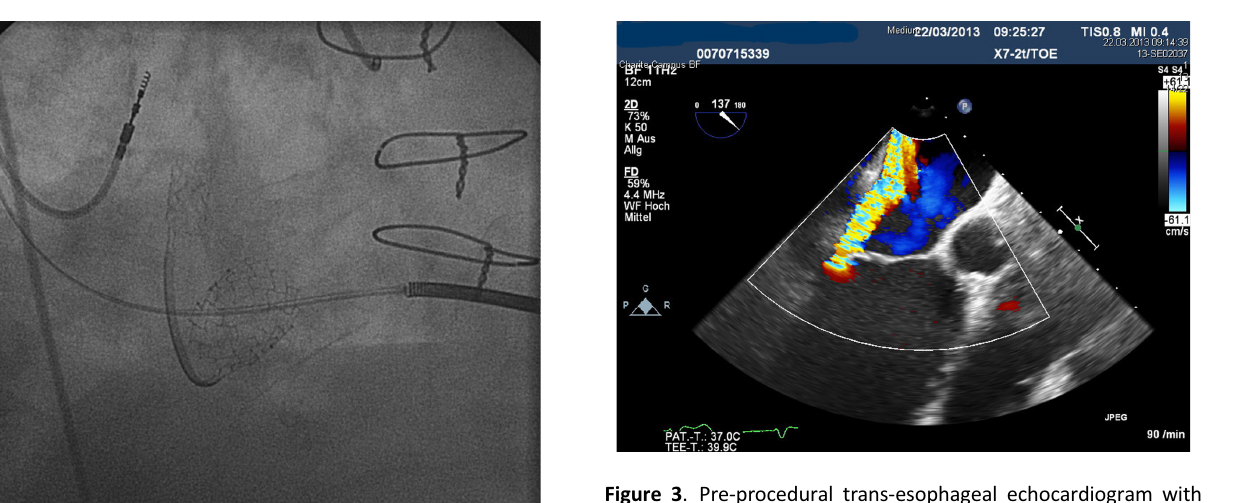
Figure 3 . Pre-procedural trans-esophageal echocardiogram with serve mitral regurgitation.